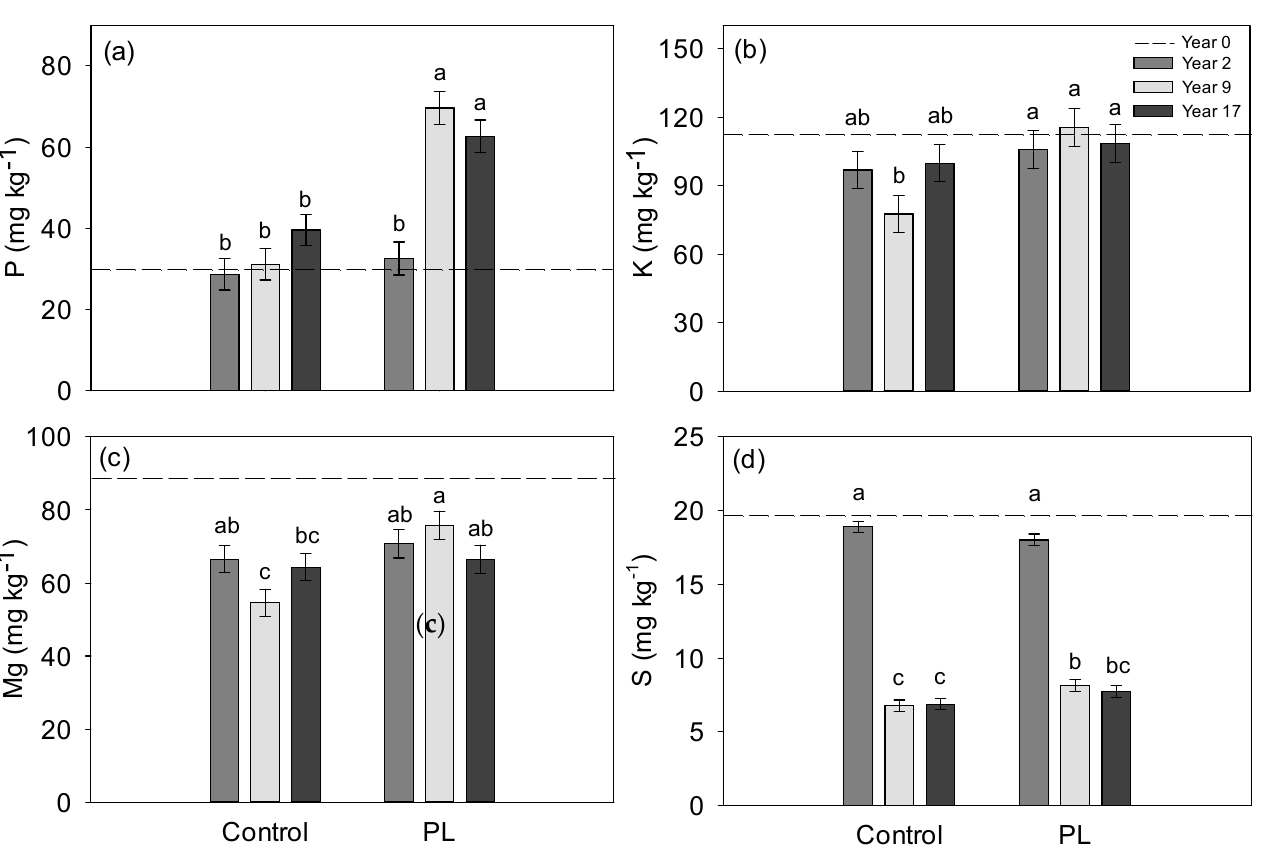
Figure 3. Selected soil chemical properties over time in a 17-year agroforestry site in Fayetteville, AR, per fertilization treatment, averaged across tree species. Dashed lines represent baseline values (1999). PL, poultry litter. Means followed by the same letter within a panel do not differ at p < 0.05. ( a ) P concentration in soil (mg kg -1 ); ( b ) K concentration in soil (mg kg -1 ); ( c ) Mg concentration in soil (mg kg -1 ); ( d ) S concentration in soil (mg kg -1